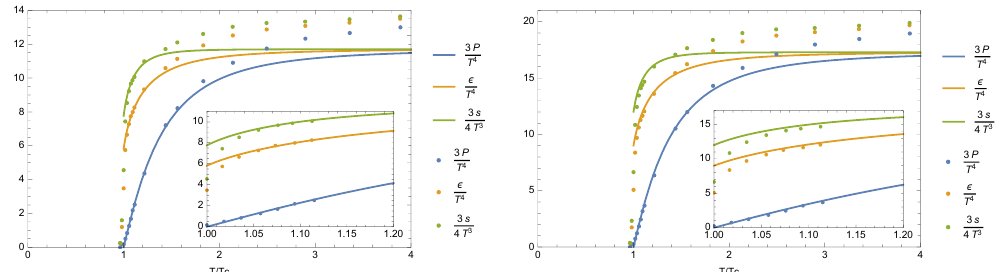
Figure 2 . Check on the large N scaling for the 4-6 PLM. Left panel: fitting the 4-6 PLM for SU(5) to the thermodynamic quantities “measured” in the lattice simulation, where the lattice data for N = 5 have been read off by using the large N scaling for the N = 6 data in [22], as noted in the text. Right panel: the same for SU(6) . For both N = 5 and N = 6 cases, we have selected a as 3 the scaling parameter (scaled from the N = 4 case), and the other parameters have been fixed by the criticality and the latent heat constraints given in eq. (2.32). See table 1 (4- 6 PLM with N = 5 and N = 6 ) for the values of the scaled a and the other fixed parameters for SU(5) and SU(6) 1 3 cases, and the goodness-of-fit. In both panels the LS fits have been performed for 1 ≤ T/T 1 . 5 c ≤ focusing only around the criticality, as zoomed-in the close-up